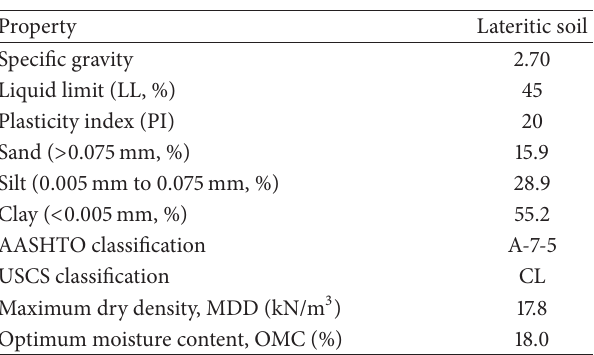
Table 1: Properties of tested